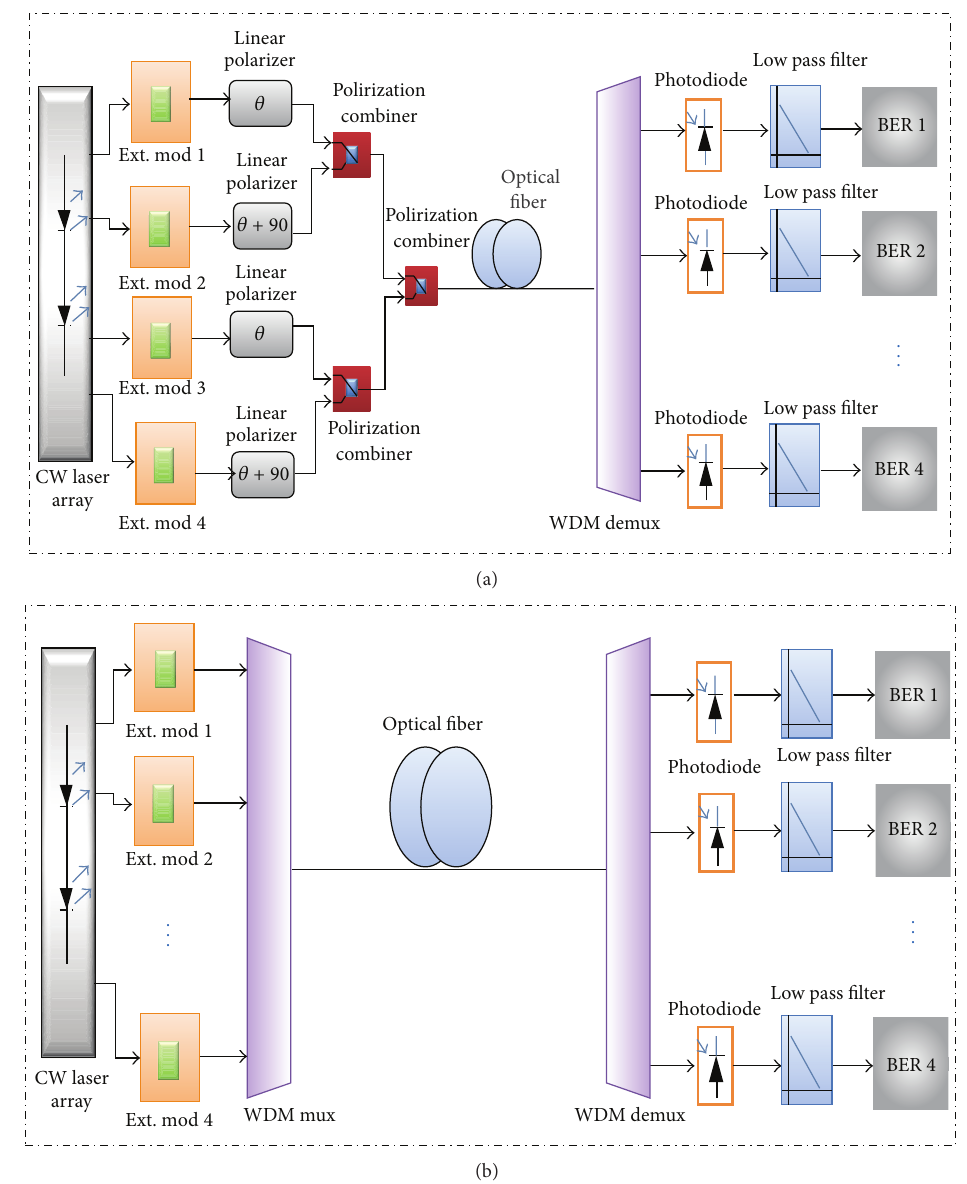
Figure 1: Optical system simulation configuration (a) proposed system and (b) conventional